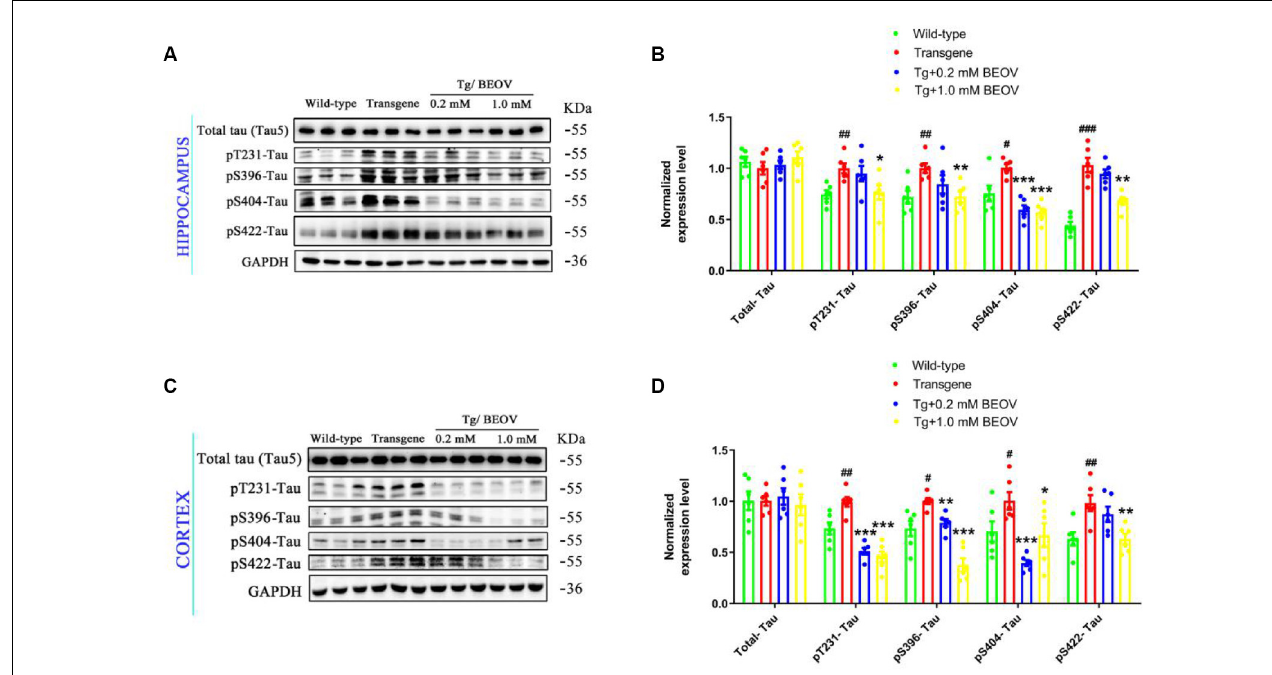
FIGURE 7 | BEOV inhibited tau hyperphosphorylation in APPSwe/PS1dE9 mice. (A,C) The level of total tau and phosphorylated tau at Thr231, Ser396, Ser404, and Ser422 were detected using Western blot both in the hippocampus and cortex of WT, APPSwe/PS1dE9, and BEOV-treated APPSwe/PS1dE9 mice. (B,D) Semi-quantification of total tau and phosphorylated tau at different amino acid positions. Quantitative results of phosphorylated tau were normalized against the levels of total tau (tau5). # WT group vs. AD group; *AD + BEOV group vs. AD group. n = 6, three females and three males; # P < 0.05, ## P < 0.01, ### P < 0.001, * P < 0.05, ** P < 0.01, and *** P < 0.001,